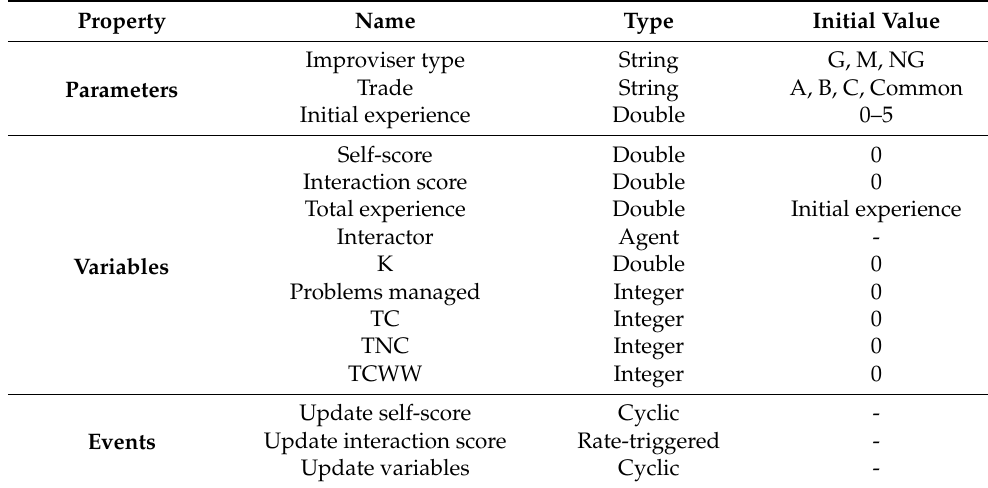
Table 4. Summary of improvisers’ parameters, variables, and related